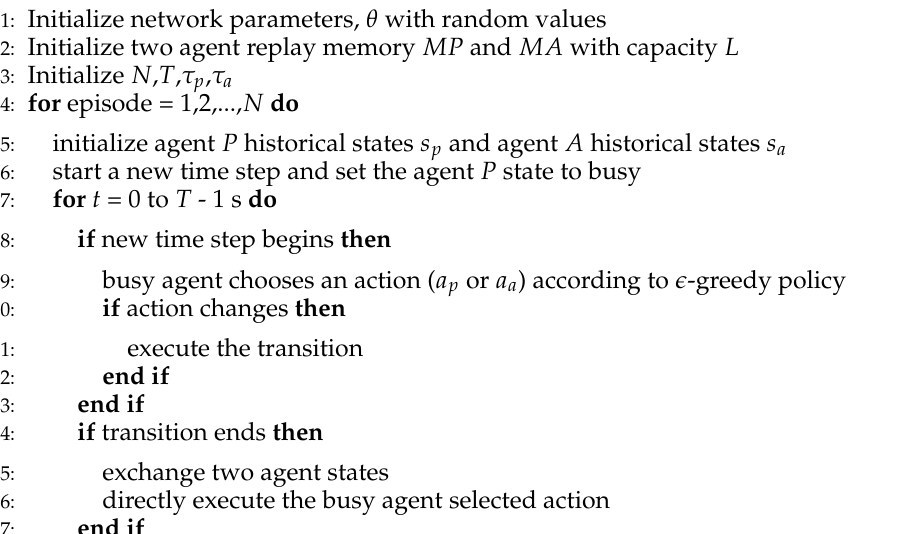
Algorithm 1 Double Deep Q-Network with Double-Agent for Traffic Light